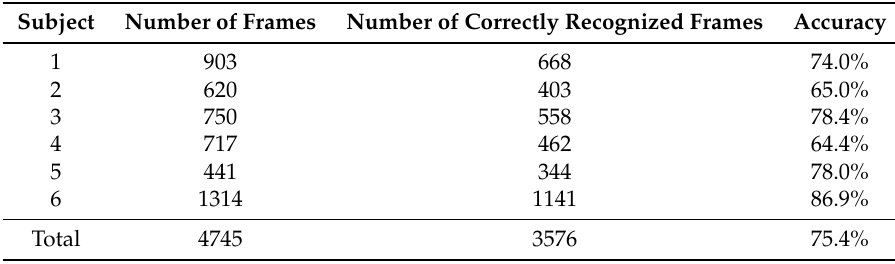
Table 4. Experimental results.